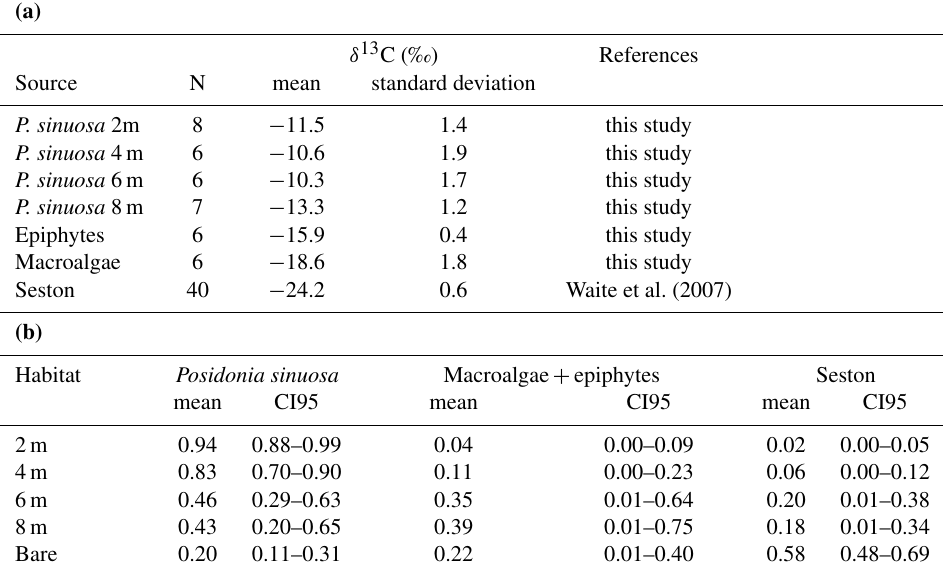
Table 4. (a) Stable carbon isotopic composition values ( δ 13 C) of potential organic matter sources used for the different sources in the Bayesian mixing models. Data for P. sinuosa detritus (sheaths, roots and rhizomes) along the cores at 2, 4, 6 and 8m water depth are presented. (b) Relative contributions of potential sources of organic carbon to soils of P. sinuosa meadows in different depths and bare sediment (over 500 years of accumulation) as modeled by SIAR. Mean and lower and upper 95% credible interval (CI95) for all the range of feasible solutions in each Bayesian mixing